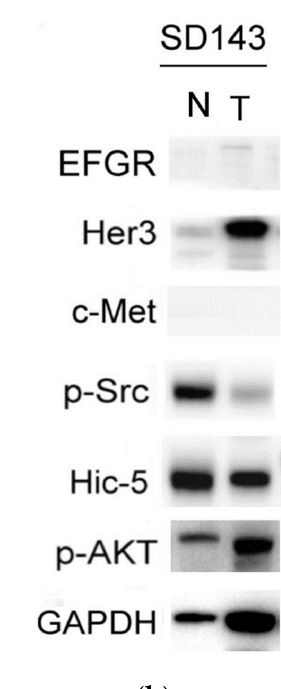
Table 1. Criteria for evaluation of Metastatic potential.